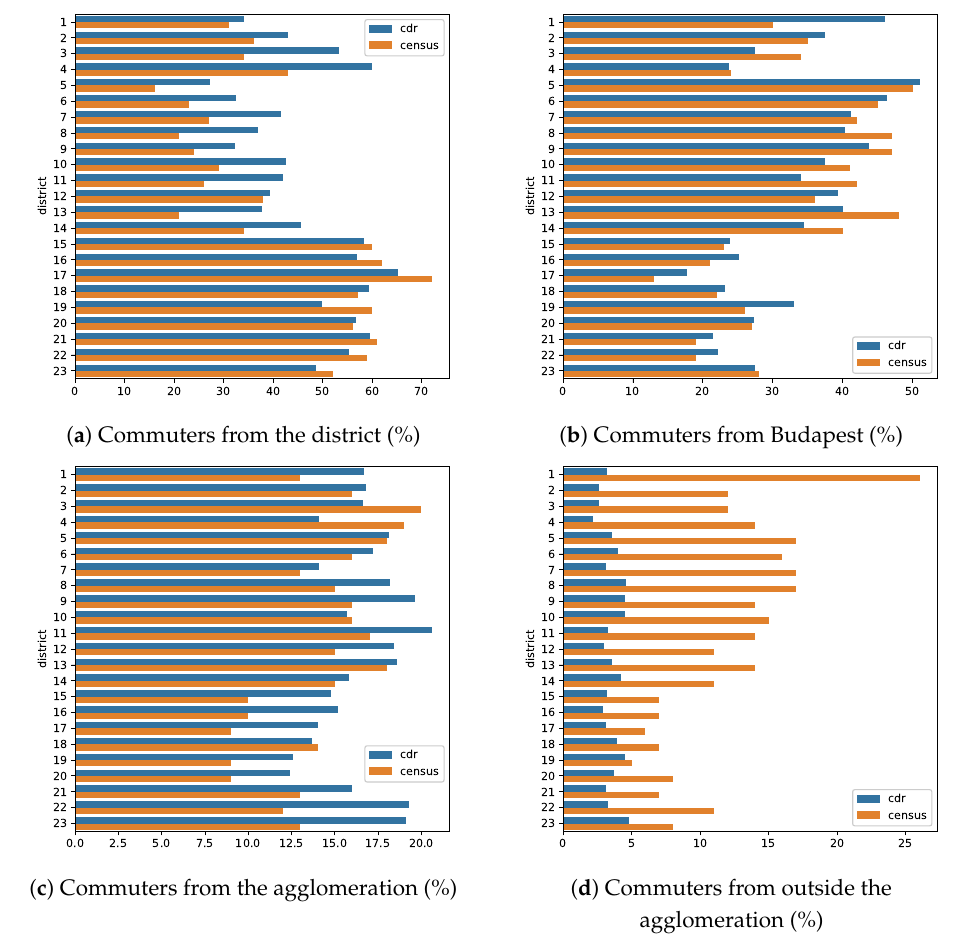
Figure 5. Comparision between the CDR and the census based (Data from [40], Figure 1) commut- ing